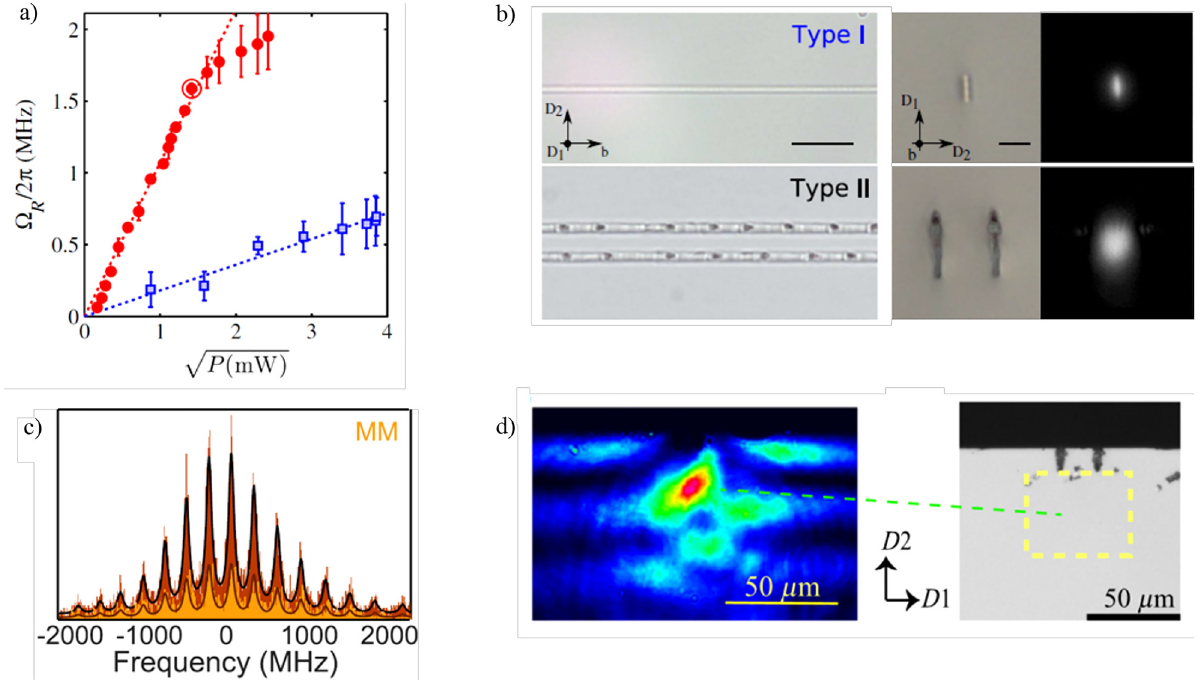
SiO (blue squares) and in a type II waveguide 2 5